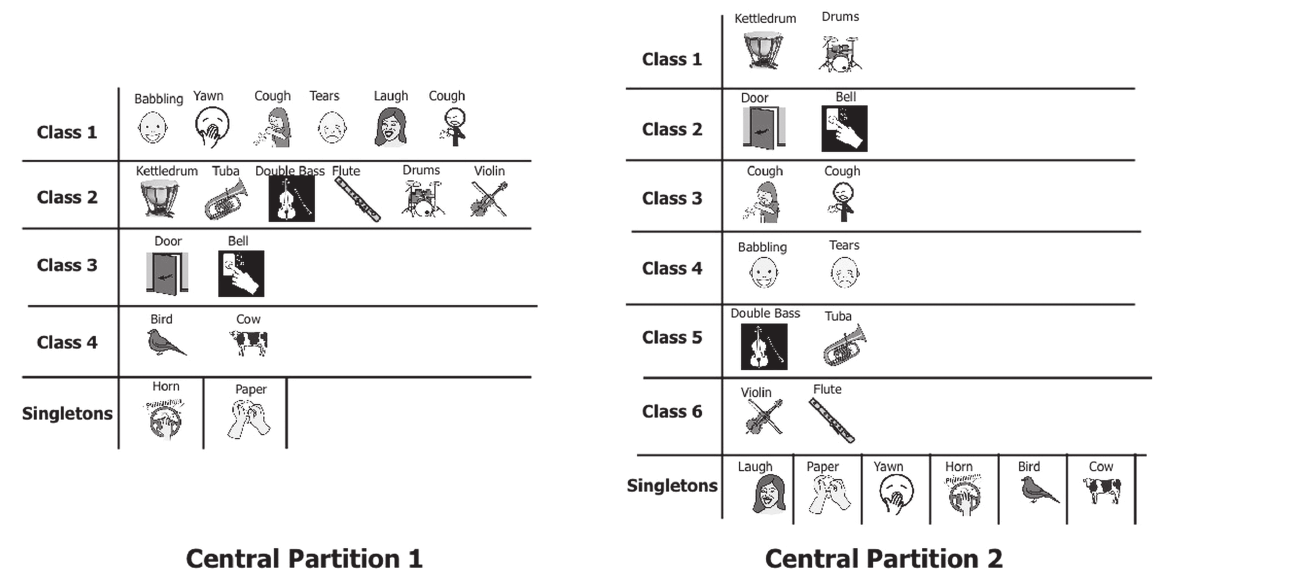
Fig 4. Illustration of the two main central partitions performed by participants, independent of the age.